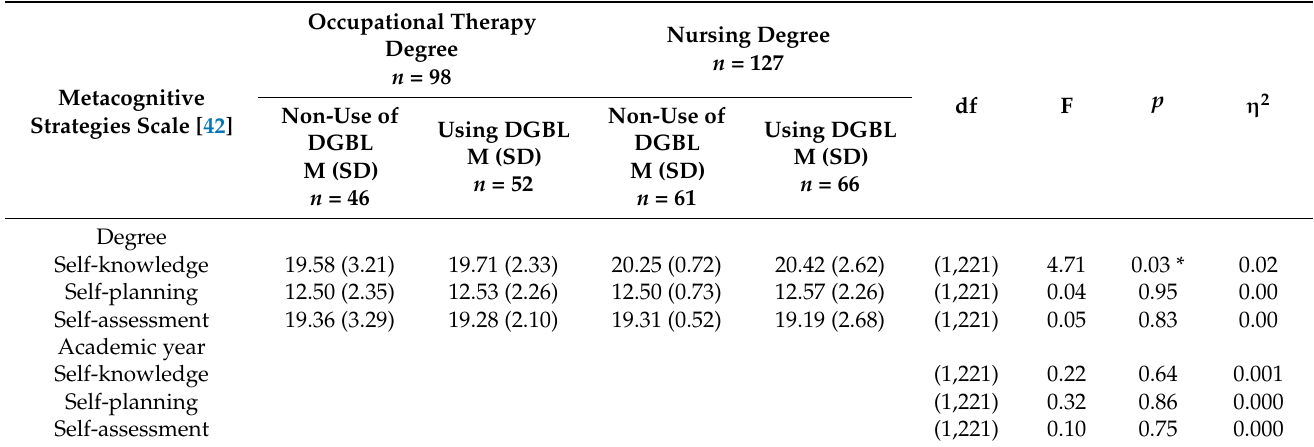
Table 3. One-factor fixed-effects ANOVA (DGBL use vs. non-use).